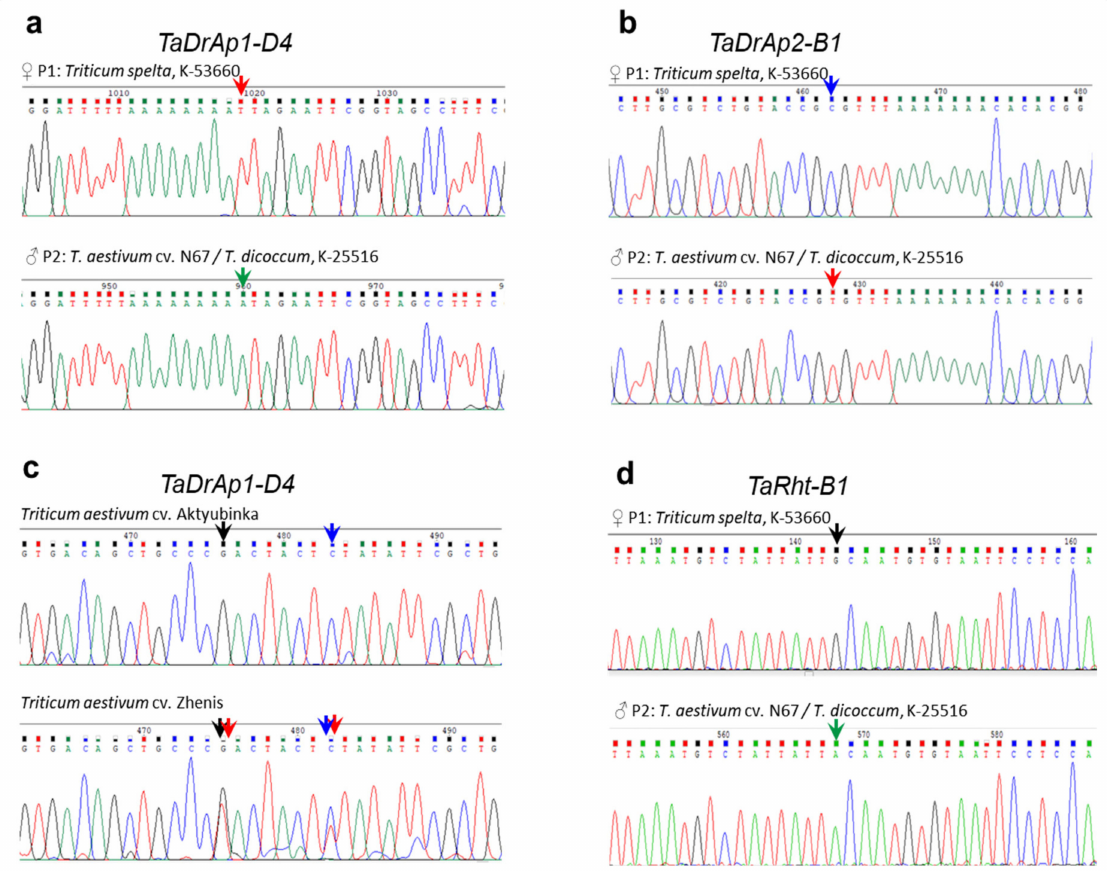
Figure 5. Example of the identified SNPs in parental forms of hybrid cross No. 18-6 in the promotor region of homeologs TaDrAp1-D4 ( a ) and TaDrAp2-B1 ( b ). SNP di ff erences among two cultivars of bread wheat in the promotor of TaDrAp1-D4 ( c ) and in the first intron of TaRht-B1 gene determining plant height ( d ). SNPs are shown by arrows in corresponding